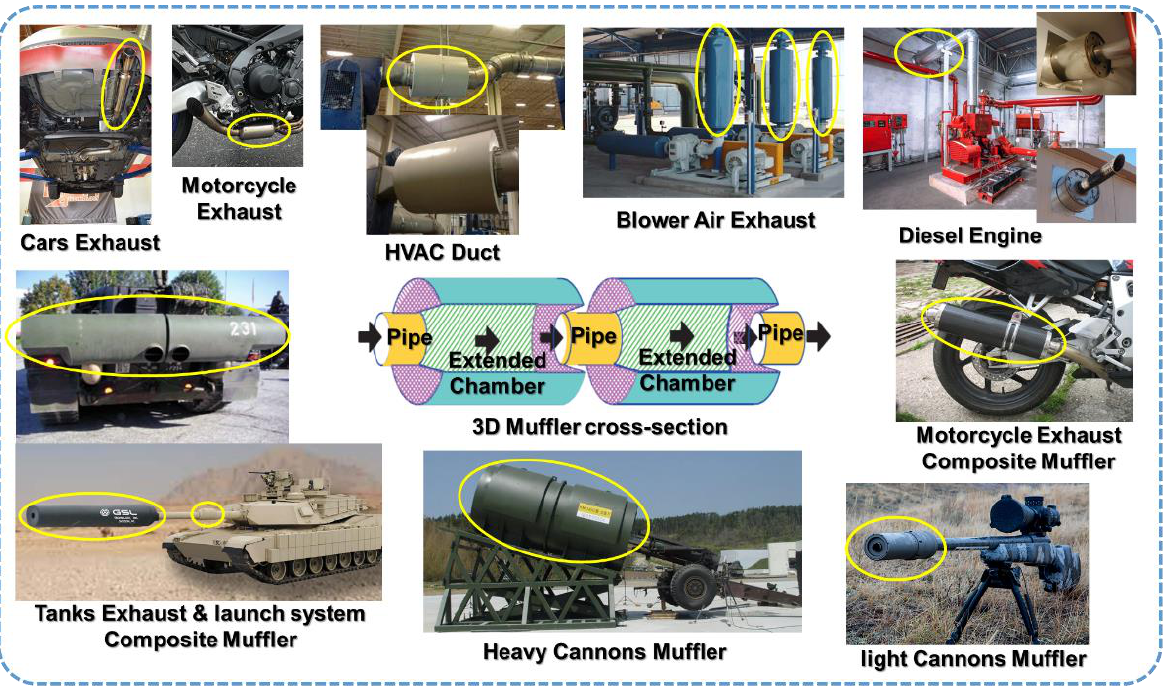
Figure 1. Examples of the Industrial and Military equipment which are connected with mufflers.